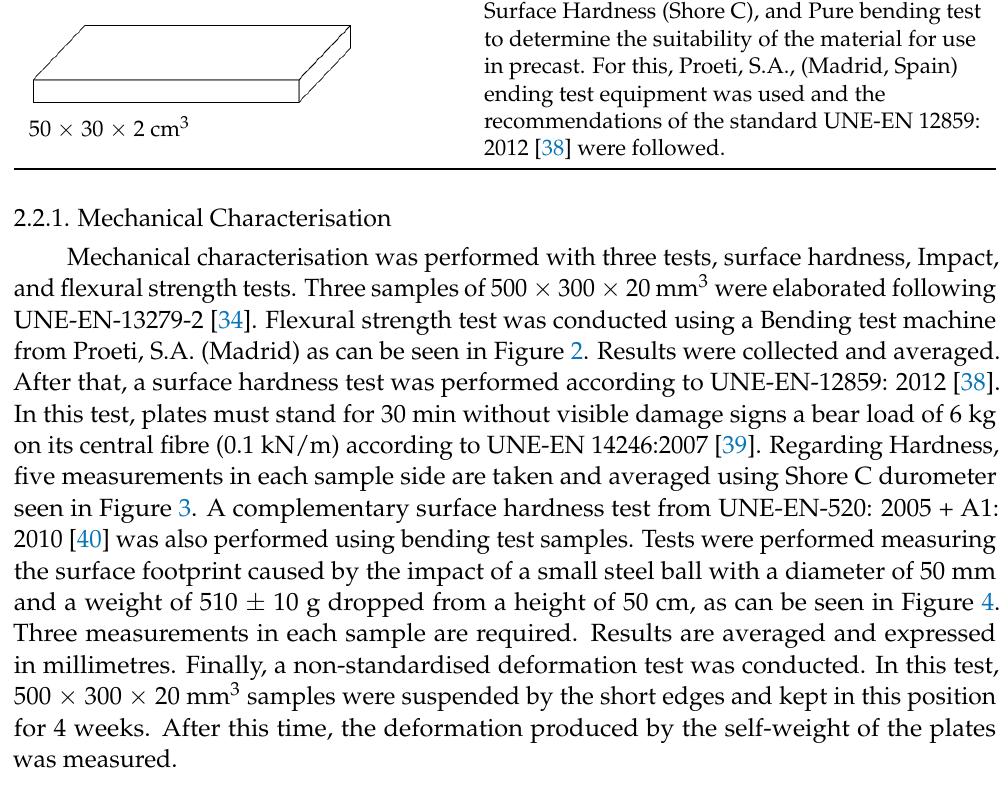
Figure 2. Bending test machine by Proeti, S.A. in Madrid.